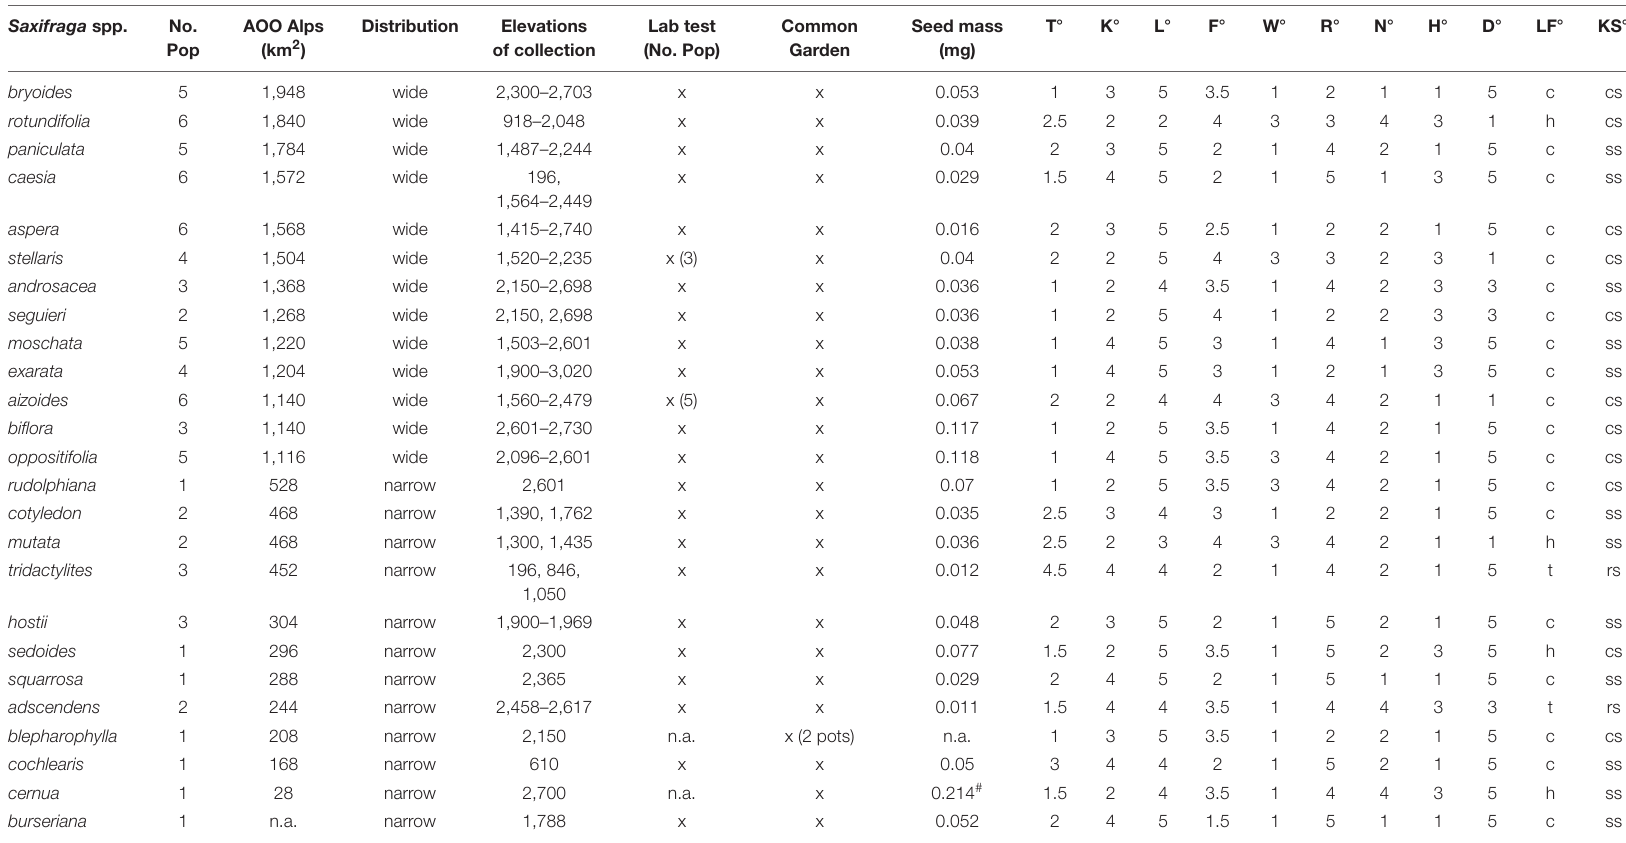
TABLE 1 | Study species of the genus Saxifraga (Saxifragaceae) having a wide or narrow distribution range (decending order by AOO), and number of populations (No. Pop) collected in the European Alps. Saxifraga